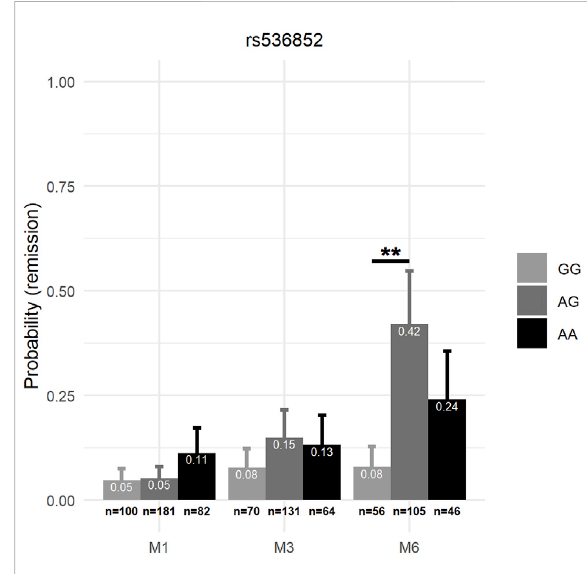
FIGURE 6 Remission rates according to rs536852 genotypes over the course of antidepressant treatment. The probability of remission ( y -axis) according to rs536852 genotypes (see legend) are shown across time ( x -axis) after controlling for age, sex, antidepressant class, ethnicity, and signi fi cantly different demographic factors (see Supplementary Table S2). Error bars correspond to the standard error estimates from mixed-effects models. **: p < 0.0011 (0.01/9). M1, 1 month after beginning antidepressant treatment; M3, 3 months after beginning antidepressant treatment; M6, 6 months after beginning antidepressant